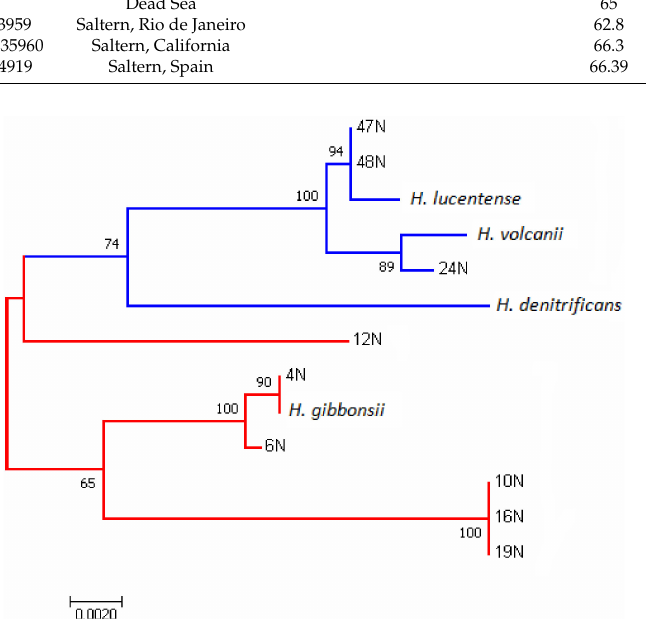
Figure 1. Molecular phylogenetic analysis of the rpoB1 gene by Maximum Likelihood. Red lines represent species and isolates with an S-layer glycoprotein corresponding to that of H. gibbonsii . Blue lines represent the species and isolates with an S-layer glycoprotein corresponding to the H. volcanii S-layer glycoprotein (see below Section 3.2). The evolutionary history was inferred by using the Maximum Likelihood method based on the Tamura-Nei model [31]. The tree with the highest log likelihood ( − 3138.94) is shown. The percentage of trees in which the associated taxa clustered together is shown next to the branches. A discrete Gamma distribution was used to model evolutionary rate differences among sites (5 categories (+G, optimized shape parameter = 0.0500)). The rate variation model allowed for some sites to be evolutionarily invariable ((+I), 47.73% sites). The unrooted tree is drawn to scale, with branch lengths measured in the number of substitutions per site. The analysis involved 13 nucleotide sequences. Codon positions included were 1st + 2nd + 3rd. All positions containing gaps and missing data were eliminated. A total of 1827 positions were in the final dataset. Evolutionary analyses were conducted in MEGA7